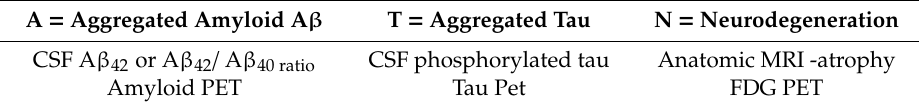
Table 1. Current pathologic criterion for AD